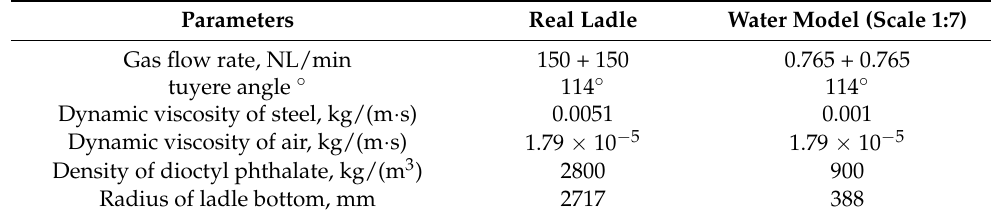
Table 1. Geometry and material